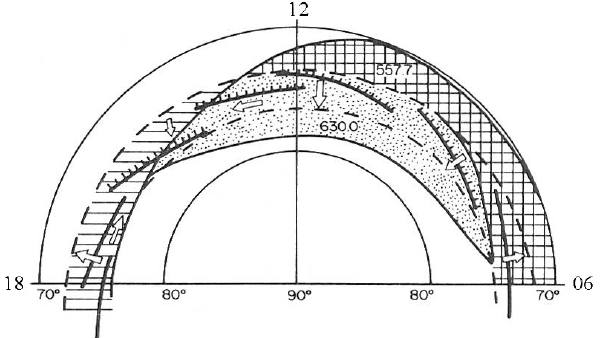
Figure 15. Distribution of the dayside auroral luminosity during a mean level of magnetic activity. Boundaries of the auroral oval are shown by dashed lines. The position of homogeneous arcs is shown by solid lines; that of rayed ones by a herringbone. The direction to the sun is upward in the figure (Leontyev et al.,